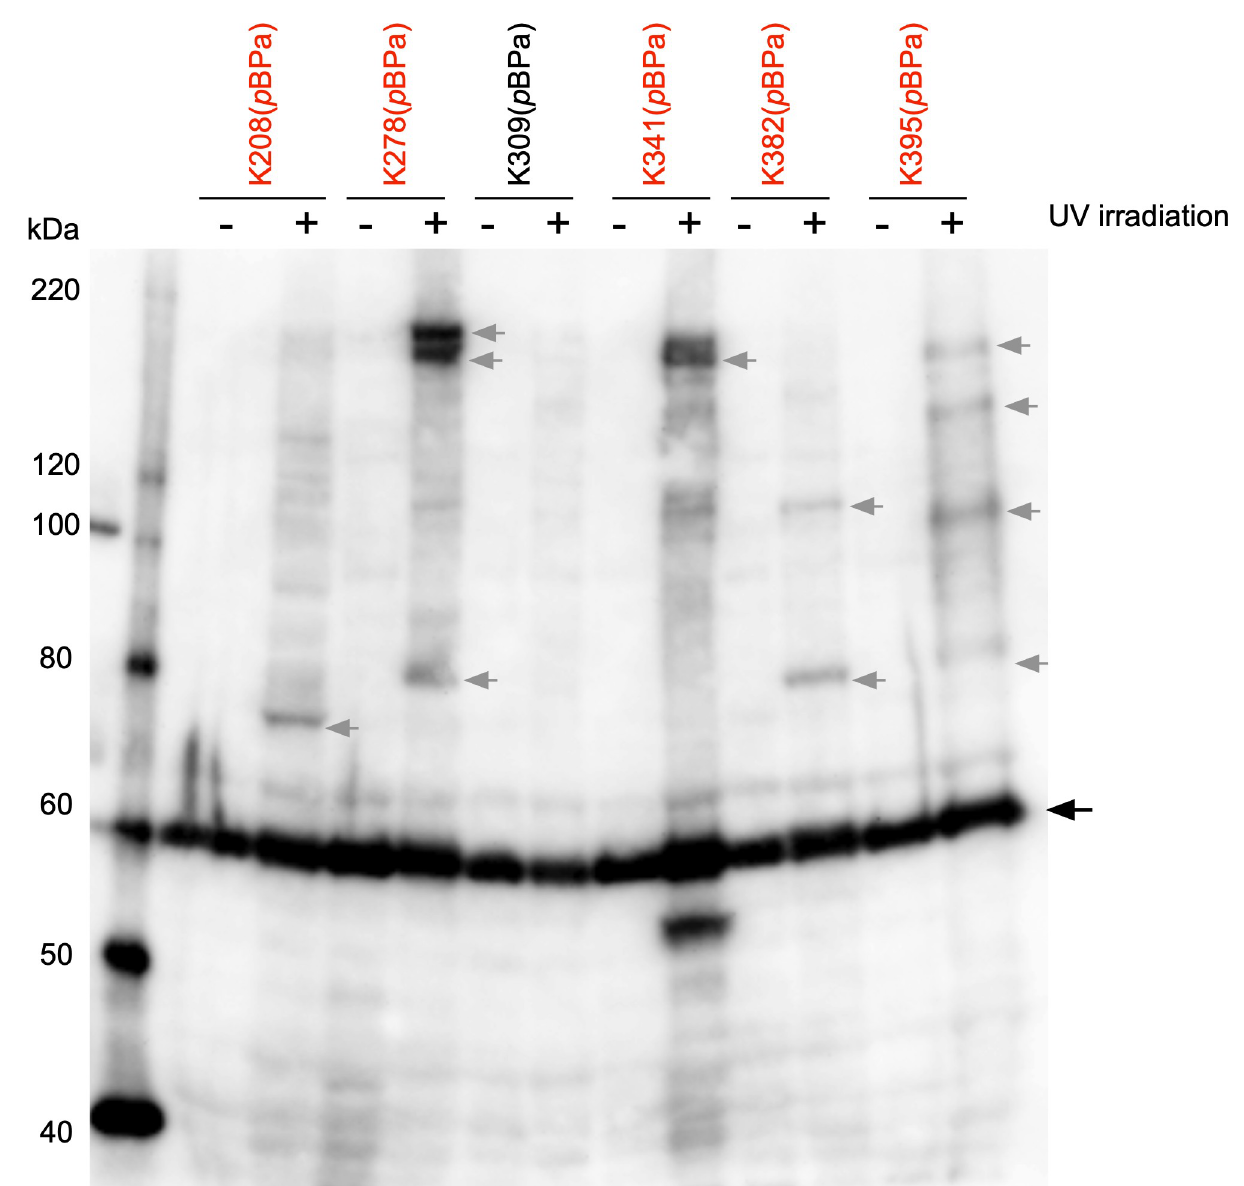
Fig 4. PamA K208( p BPa), PamA K278( p BPa), PamA K314( p BPa), PamA K382( p BPa) and PamA K395( p BPa) proteins crosslinked to unidentified endogenous proteins in N . meningitidis . UV crosslinking of Pam K208amb, K278amb, K309amb, K341amb, K395amb, and K382amb mutants expressed by pyrrolysine-based amber suppression with p BPa in Δ pamA N . meningitidis . Bacteria that grew on one-fourth of a GC agar plate in the presence of 1 mM p BPa were crosslinked by UV light irradiation for 2 hours and then the PamA K( p BPa)-His 6 protein was purified. An aliquot was analyzed by anti-His 6 mAb. The black arrow shows the full-length PamA K-amb protein expressed by pyrrolysine-based amber suppression with p BPa, and the gray arrow indicates protein complexes crosslinked between PamA K( p BPa) and unidentified endogenous proteins in N . meningitidis .